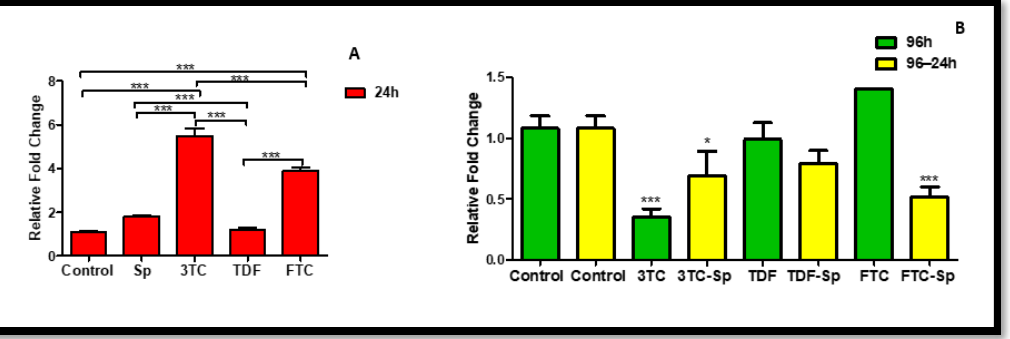
Figure 3. Effects of SP and HAART (3TC, TDF, and FTC) on the miR-155 levels. MiR-155 levels after exposure of HepG2 cells to ( A ) SP and HAART for 24 h, ( B ) HAART (96 h), and HAART (96 h) followed by SP (24 h); * p < 0.05, *** p < 0.0001.